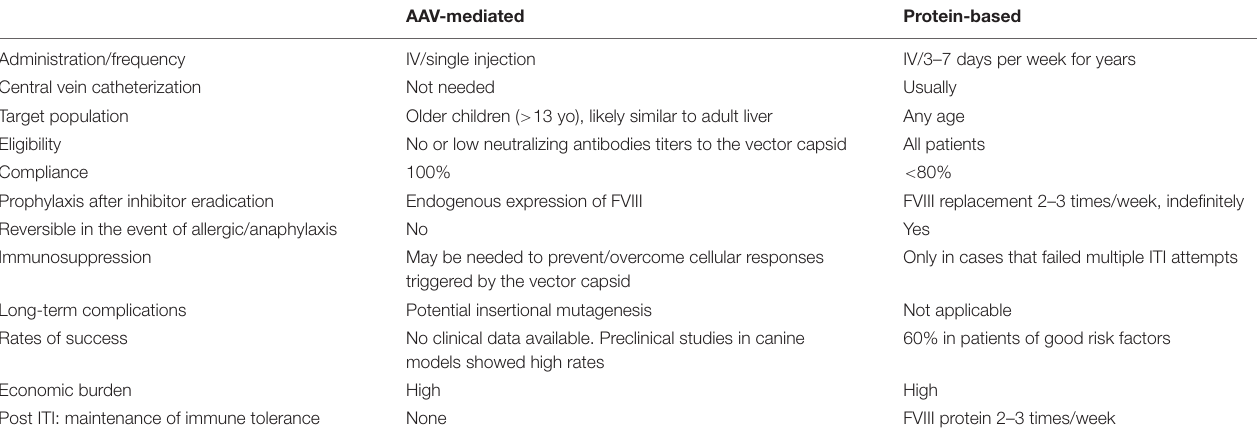
TABLE 4 | Comparison of AAV-liver gene therapy versus protein-based FVIII for immune tolerance induction (ITI).